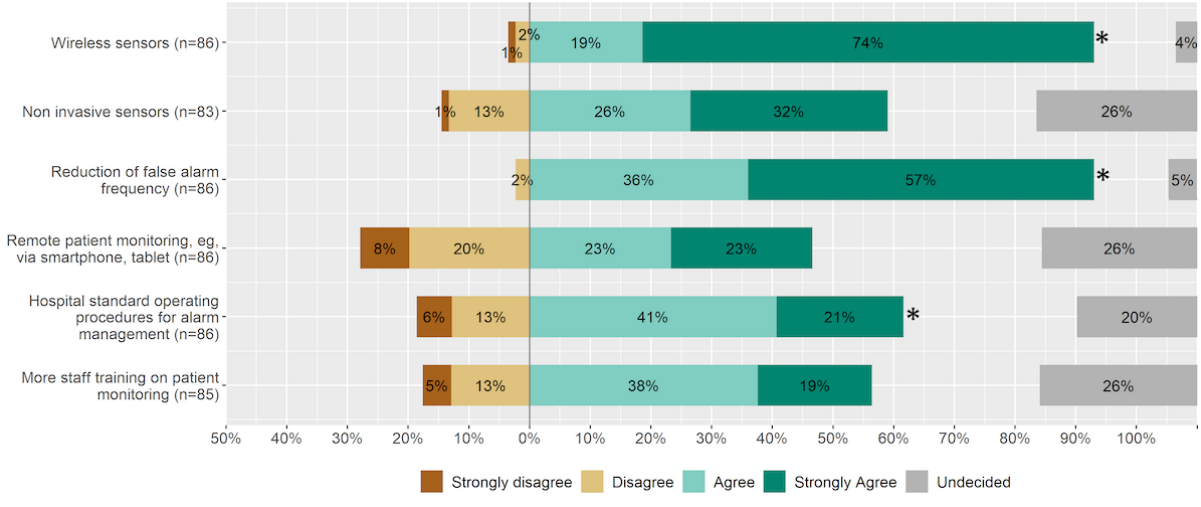
Figure 3. Improvements for future patient monitoring in the ICU. An asterisk indicates statistical significance. ICU: intensive care